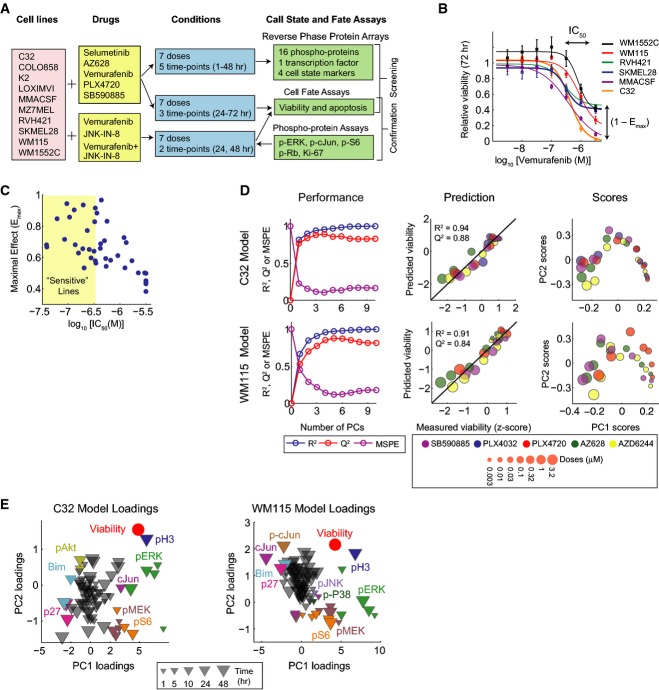
Data-driven modeling reveals signaling correlates of BRAF-mutant melanoma cellular response to RAF/MEK inhibition

Overview of the systematic measurements using single-cell phenotypic and multiplex biochemical assays to profile signaling biochemistry and cell state in 10 BRAFV600E/D melanoma cell lines exposed to four RAF inhibitors and one MEK inhibitor at multiple doses and times. Multiplex single-cell immunofluorescence assays were used in the follow-up experiments on selected cell lines for treatments with vemurafenib, JNK-IN-8, and their combination.

Dose–response curves representing 72-h viability measurements for six selected BRAFV600E melanoma cell lines after treatment with vemurafenib. Ranges of estimated IC50 and Emax for the selected lines are shown. Data are represented as mean ± SD.

Pairwise distribution and correlation of estimated IC50 and Emax values for responses (72-h viability) of 8 cell lines to four RAF inhibitors and one MEK inhibitor. Each dot represents one drug/cell line combination. Sensitive cell lines are arbitrarily defined based on their IC50s (the most widely used metric for evaluation of drug response; log10[IC50] < −6.5).

Cell line-specific model calibration for two selected cell lines C32 and WM115. Left: R2, Q2, and MSPE for C32 and WM115 models built with increasing numbers of PLSR components. Middle: Relative viability as measured experimentally (z-score-scaled) or as predicted by the three-component PLSR models using tenfold cross-validation. R2 reports model fit, and Q2 reports model prediction accuracy. Right: PLSR score plots for the first two components of C32 and WM115 models. Shown PLSR models were developed using RPPA data from Supplementary Dataset S3.

PLSR loading plots for the first two components of C32 and WM115 models.

Source data are available online for this figure.